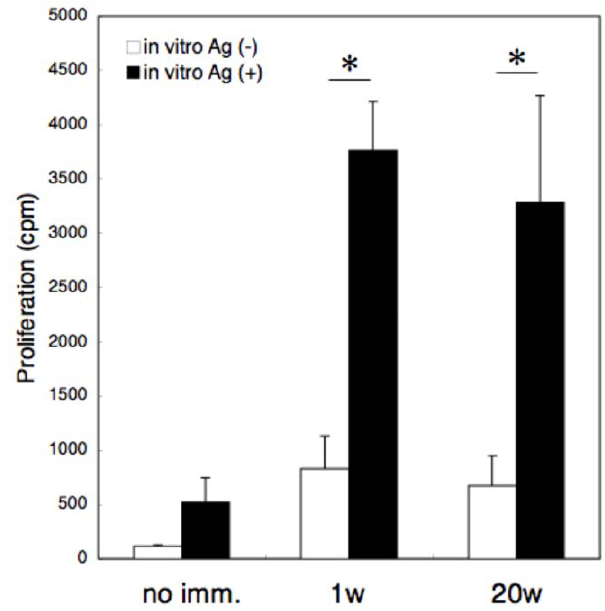
Figure 4. Antigen-specific CD8 + T-cell proliferation assay. Mice were immunized with OVA 257-264 -liposome and 1 week or 20 weeks later, CD8 + T cells of the immunized mice were cultured in the presence (closed box) or absence (open box) of OVA as described in Materials and Methods. Data represents mean 3 H- thymidine incorporation and SE of triplicate cultures. *, significant difference (p .